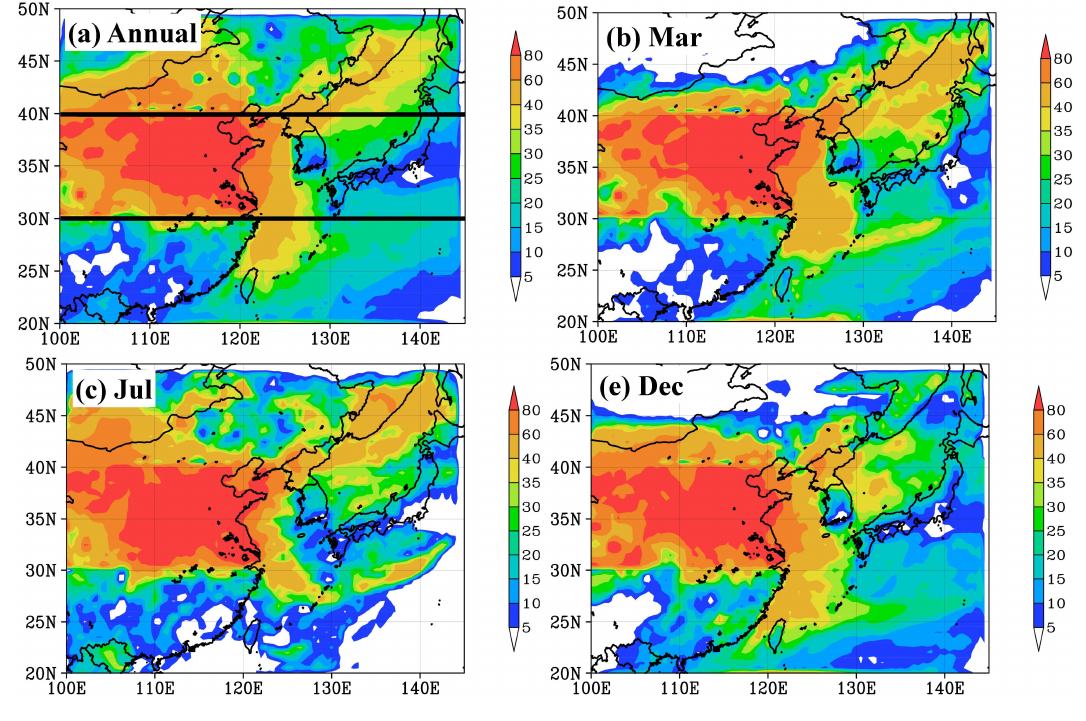
Fig. 6. Same as Fig. 5 but for Source region II.